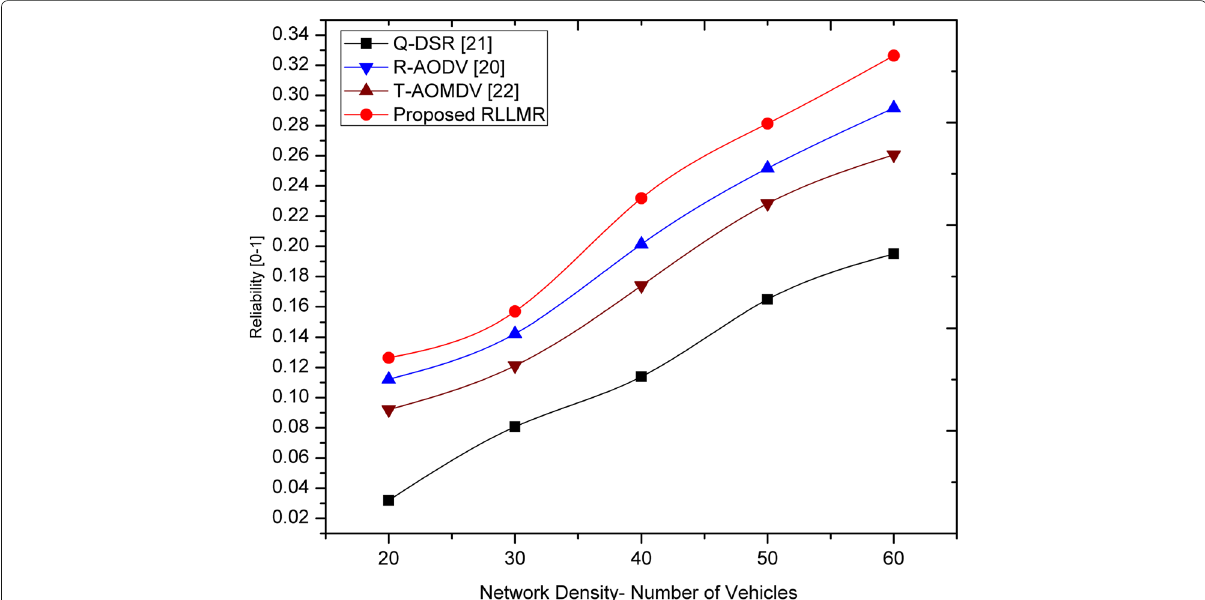
Fig. 8 Effect of different vehicles over link reliability (average speed 60 km/h, R 1000 m, t 10